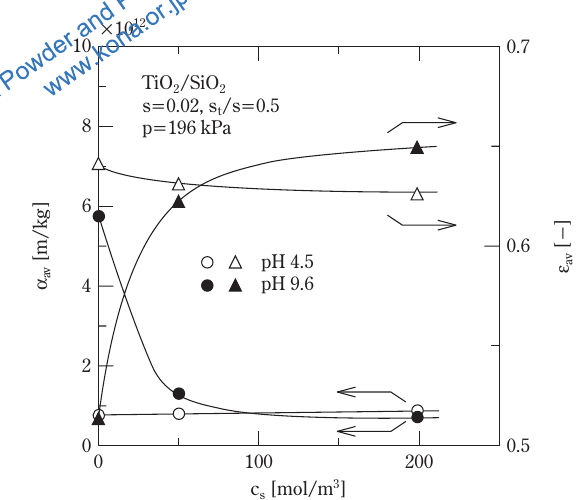
Fig. 20 Effect of NaCl concentration on average specific filtration resistance and average